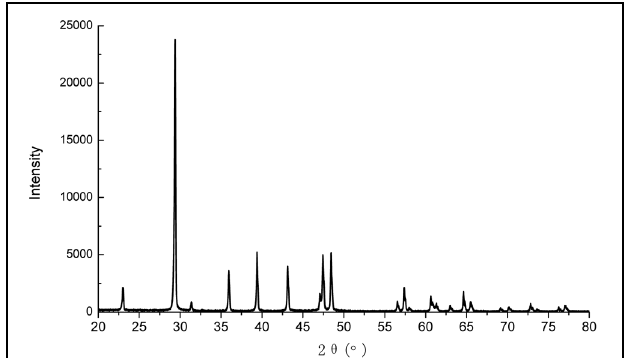
FIGURE 3 | X-ray diffraction (XRD) pattern of the